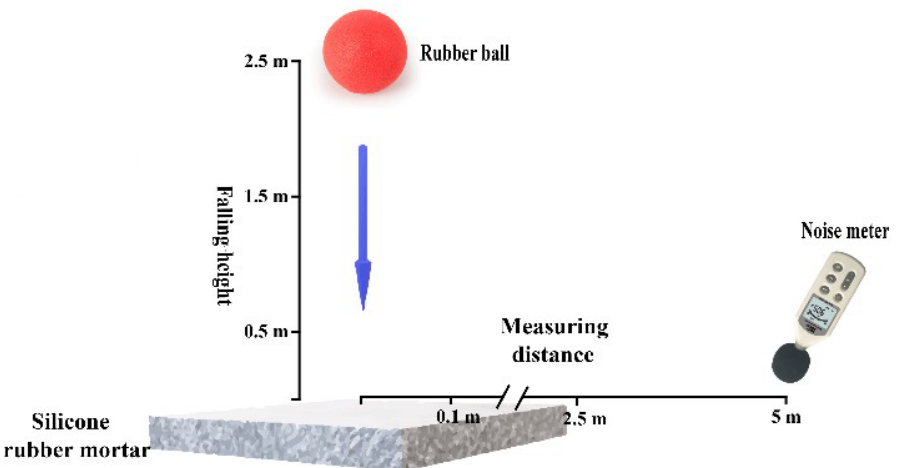
Figure 4. Self-made rubber ball impact test device.